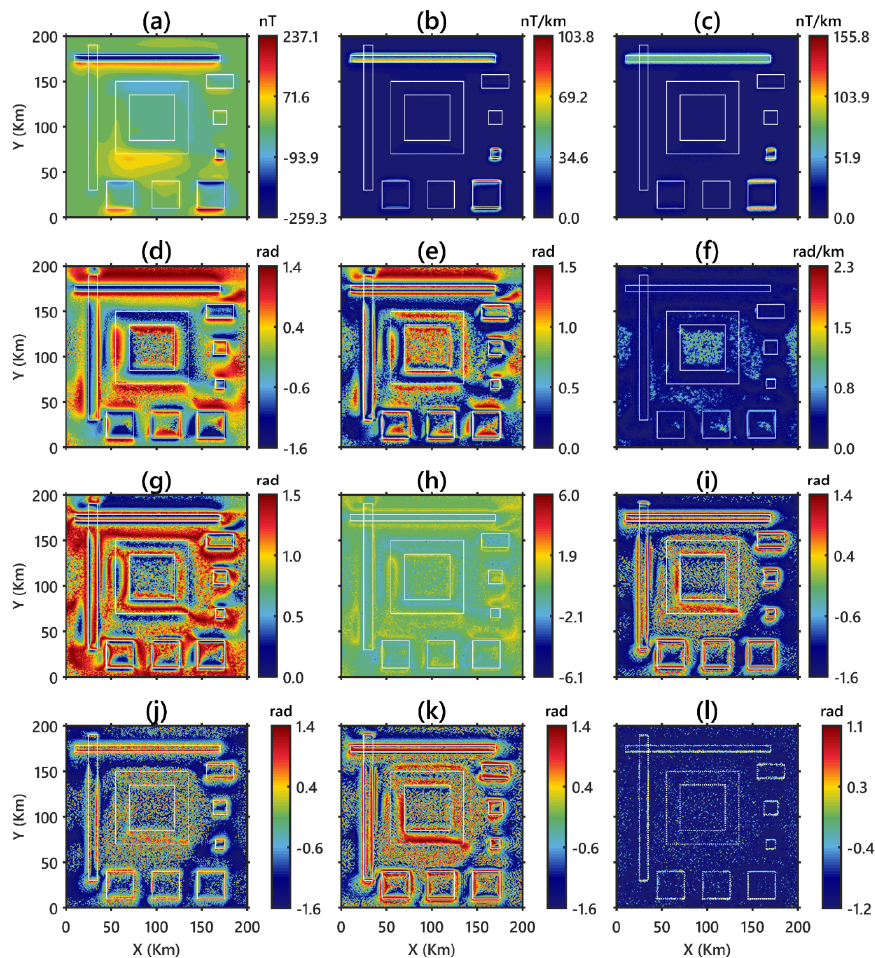
Figure 7. The fourth case. ( a ) The magnetic anomaly; ( b ) HG; ( c ) AS; ( d ) TA; ( e ) TM; ( f ) HGTA; ( g ) TDX; ( h ) HTA; ( i ) TAHG; ( j ) TAAS; ( k ) TBHG; and ( l ) ETG. The white lines show the true edge of the prisms.